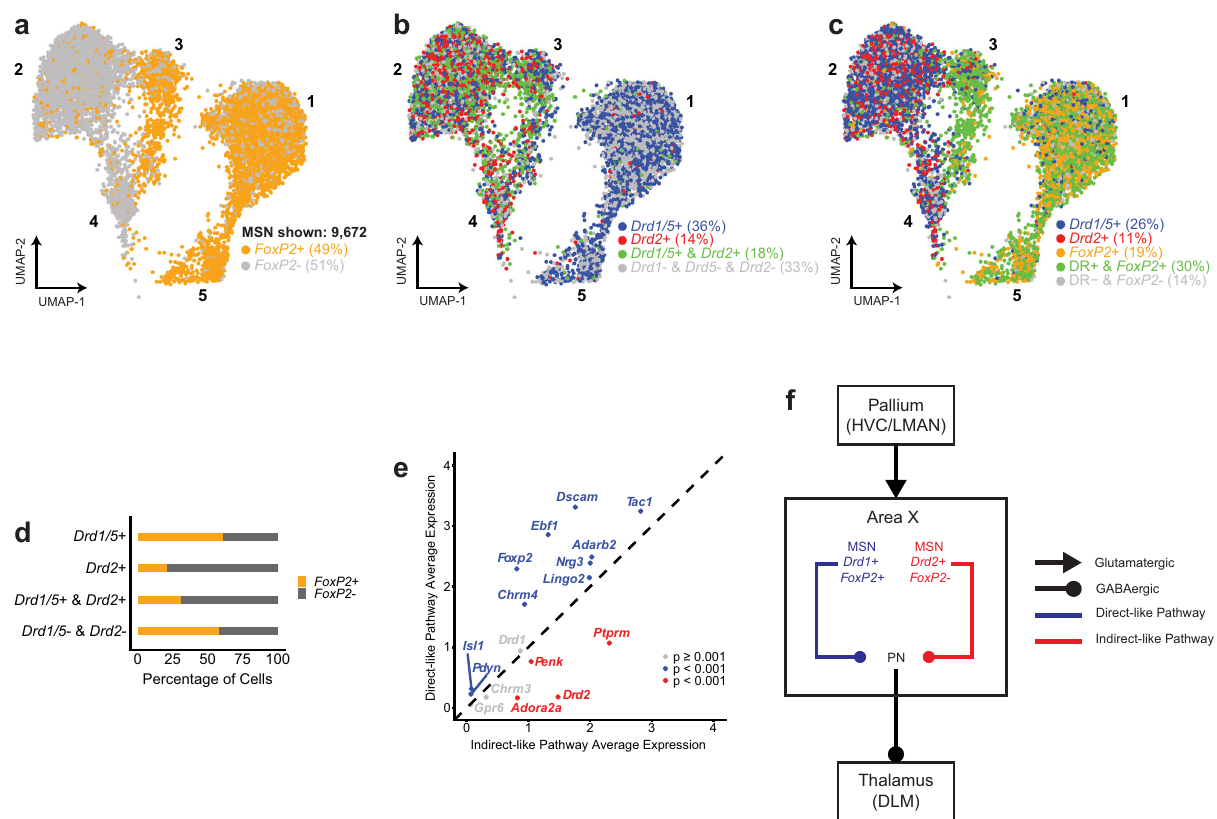
Fig. 5 Patterns of FoxP2 and dopamine receptor expression in Area X. a UMAP projection of MSN clusters. Nuclei are colored based on Foxp2 expression: FoxP2 + (orange) or FoxP2 − (gray). Percentages are rounded and re fl ect a proportion of the total number of MSNs. b UMAP projection of MSN clusters. Nuclei are colored based on the exclusive expression of Drd1/5 (blue), Drd2 (red), both (green), or neither (gray). Percentages are rounded and re fl ect a proportion of the total number of MSNs. c UMAP projection of MSN clusters. Nuclei are colored based on the exclusive expression of Drd1/5 (blue), Drd2 (red), FoxP2 (orange), any dopamine receptor and FoxP2 (green), or none (gray). Percentages are rounded and re fl ect a proportion of the total number of MSNs. d A stacked bar plot illustrating the percentage of nuclei expressing FoxP2 , classi fi ed by dopamine receptor expression. e A scatter plot showing the differential expression of genes that distinguish nuclei grouped into a putative direct-like pathway (clusters 1 and 5) and indirect-like pathway (clusters 2, 3, and 4). Blue indicates direct-like pathway genes with p < 0.001, red indicates indirect-like pathway genes with p < 0.001, and gray indicates genes with p ≥ 0.001. f A hypothesized model for the circuitry of MSNs in Area X based on these